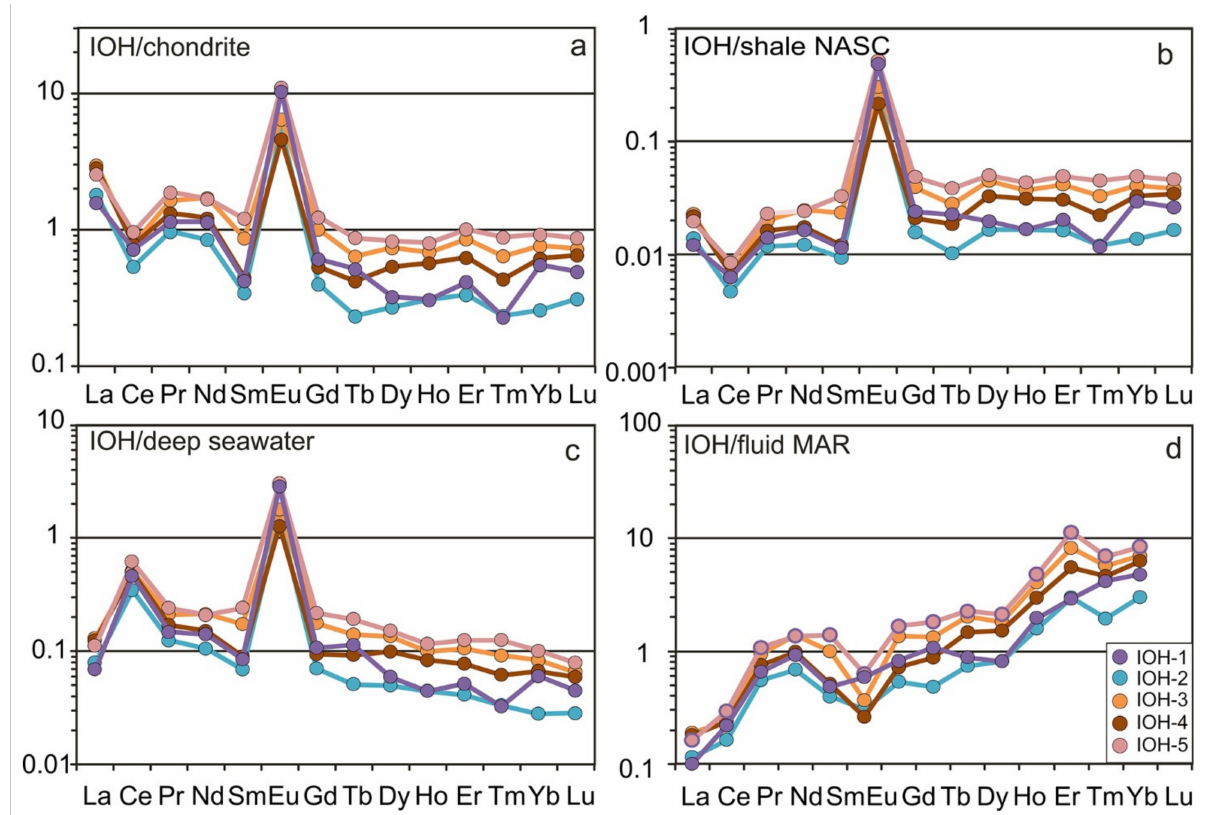
Figure 10. REE patterns of the IOHs of the Pobeda-1 hydrothermal field normalized to: ( a ) chon- drite [99], ( b ) NASC [92], ( c ) deep seawater [100], and hydrothermal fluids of the MAR ultramafic- hosted Rainbow (brown lines), and ( d ) basalt-hosted Broken Spur, Snake Pit, Lucky Strike and TAG hydrothermal fields (green lines)